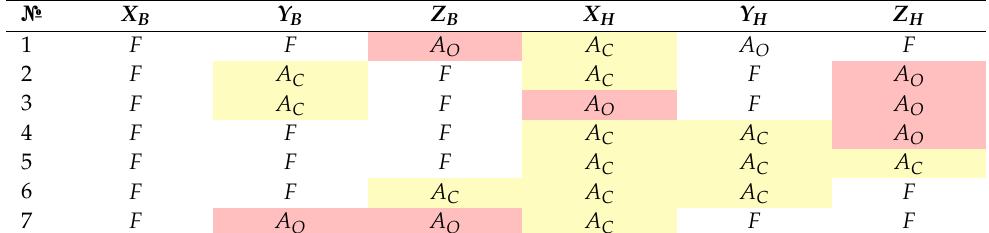
Table A8. Full classification of existing Cartesian 3D printers.